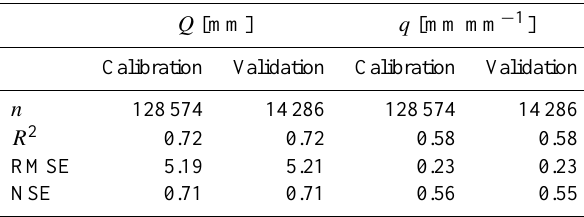
Table 3. Calibration and validation results of accumulated runoff volumes ( Q) and instantaneous runoff rates ( q) for all 317 hydro- graphs used in a ten-fold cross validation; Goodness-of-fit param- eters were calculated based on the full model/data resolution of 1min; NSE is Nash–Sutcliffe efficiency (Nash and Sutcliffe, 1970), R 2 is the coefficient of determination, and RMSE is the root mean square error; n indicates the number of single measurements used for calibration and validation. Q [mm]